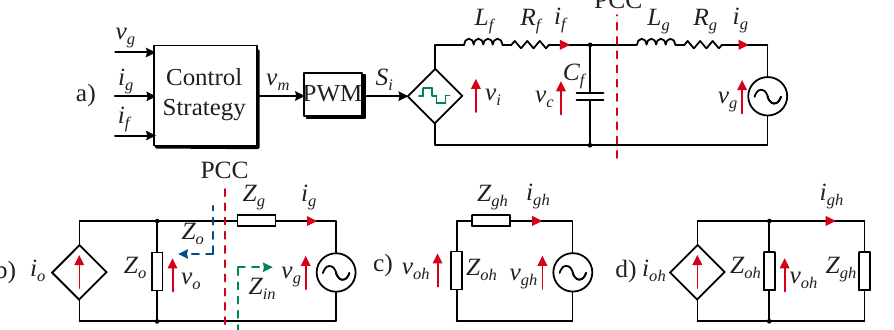
Figure 6. Impedance representation: ( a ) single-phase model, ( b ) Norton model approach, ( c ) series resonance, and ( d ) parallel